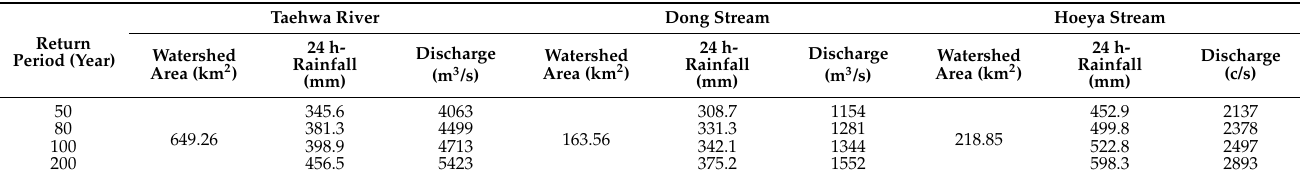
Table 6. Rainfall and discharge according to return period by river and stream.